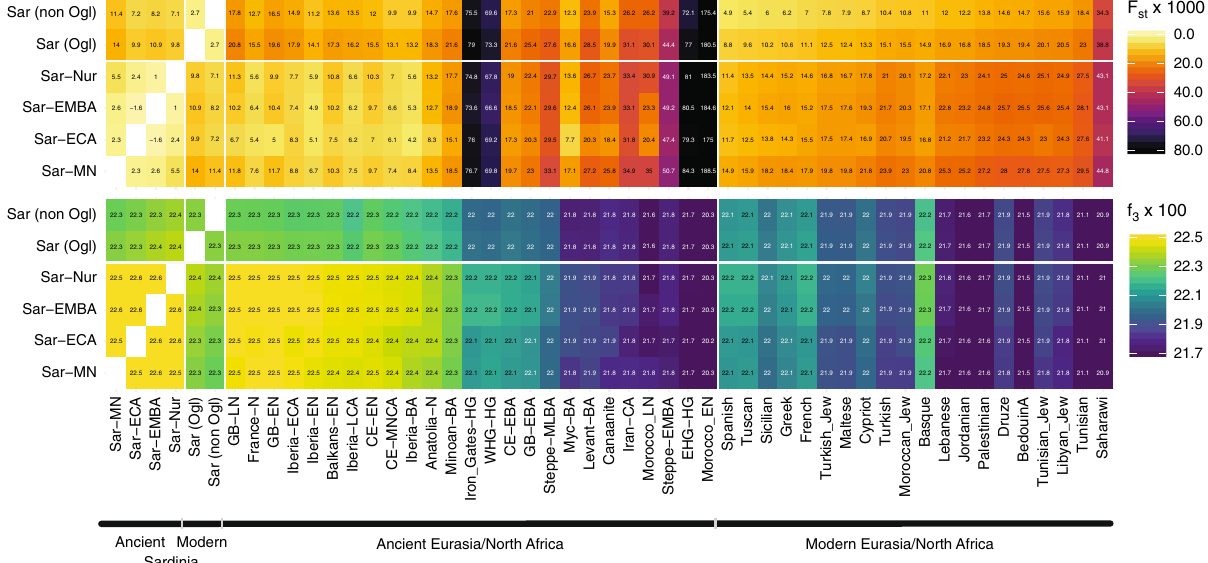
Fig. 3 Genetic similarity matrices. We calculated F ST (upper panel) and outgroup- f 3 (lower panel) of ancient Sardinian (Middle/Late Neolithic to Nuragic periods) and modern Sardinian individuals (grouped into within and outside the Ogliastra region) with each other (left), various ancient (middle), and modern populations (right) of interest. The full sharing matrices can be found in Supp. Figs. 10/11, where we also include post-Nuragic sites. For ancient groups, sample sizes and time-spans are provided in Fig 1d. The full set of labels and abbreviations are described in Supp. Data 1E, F.